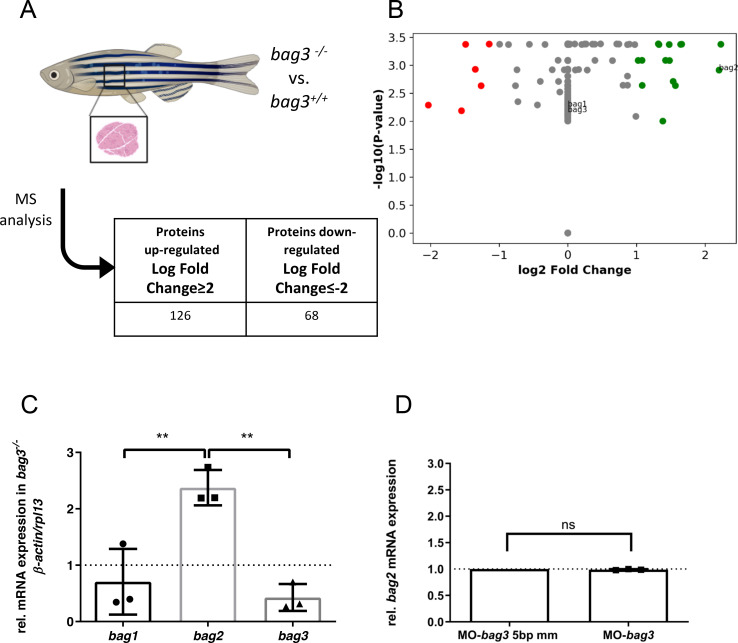
Bag2 mediates genetic compensation in bag3 knockout zebrafish.(A) Schematic description of proteomic workflow. Acquired spectra were analyzed against the Uniprot zebrafish database using MaxQuant. (B) Detection levels of label free quantification (LFQ) intensity ratio between bag3-/- and bag3+/+ zebrafish samples of three orthologs of the Bag family protein, Bag1, Bag2 and Bag3. The values are shown as Log2 fold change ≥2 and ≤2. (C) Quantitative real-time PCR of bag3-/- and bag3+/+ zebrafish embryos at 72 hpf shows significant upregulation of bag2 mRNA levels, whereas bag1 transcript levels are not increased (N = 3, mean±S.D, One-way ANOVA followed by tukey's multiple comparison analysis **bag1 vs bag2 P = 0.0057, ** bag2 vs bag3 P = 0.0026). (D) Quantitative real-time PCR of MO-bag3- or MO-bag3 5bp mm-injected embryos shows no upregulation of bag2 mRNA levels in bag3 morphants at 72 hpf. (n = 3, mean±S.D, P = 0.1080 determined using two-tailed t-test).